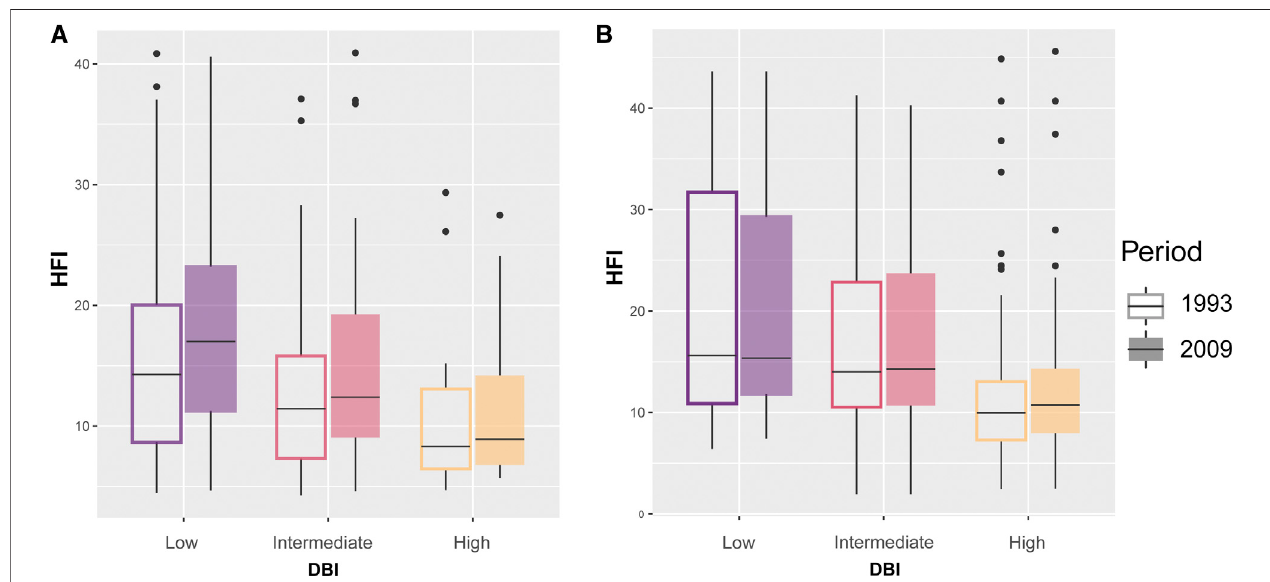
FIGURE 6 | Change in human footprint index (HFI) for odonate assemblages with low, intermediate, and high mean Dragon fl y Biotic Index (DBI) in the Mediterranean climate of (A) the North African region (NAR) and (B) South African region (SAR) between 1993 and 2009.